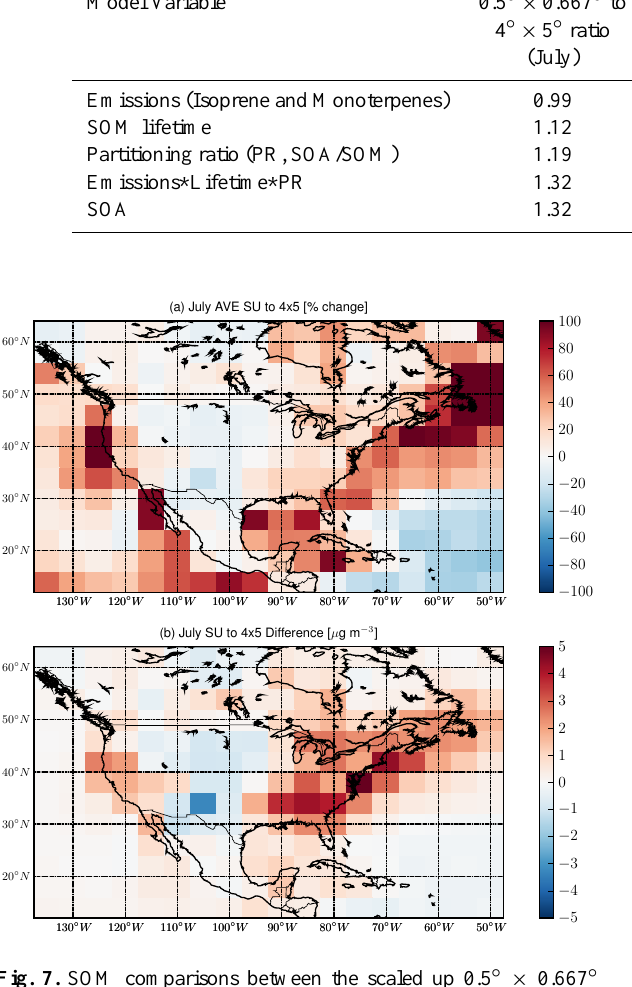
Fig. 7. SOM comparisons between the scaled up 0.5 ◦ × 0.667 ◦ simulations (SU) and the 4 ◦ × 5 ◦ simulations averaged over July. Panel (a) is the % difference between the SU and 4 ◦ × 5 ◦ SOM and (b) is the absolute difference (µg m − 3 )